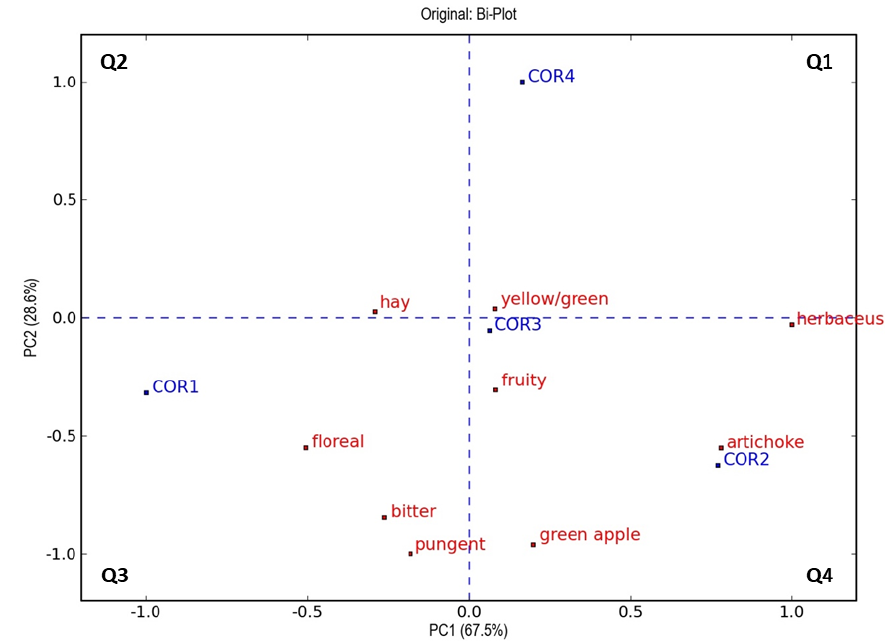
Figure 4. Representation of objects and variables (bi-plot) on the plane of the two principal components (PCA) relating to the results obtained through sensory evaluations of all virgin olive oils of cv. Coratina and the attributes evaluated. The variables and objects are marked in red and blue, respectively. The four quadrants are coded as Q1–Q4